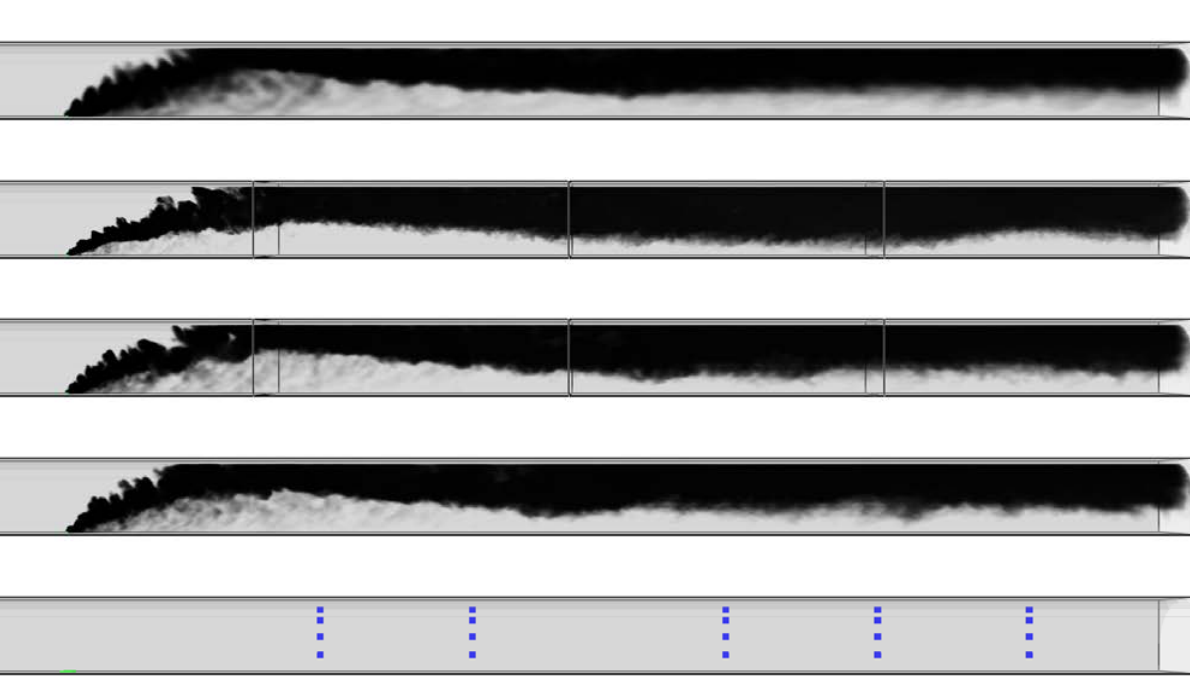
Fig 3. Aerosol movements in the tunnel for simulations 20cm, 5cm-8M, 10cm-8M and 10cm after 200 s and the position of detectors of optical